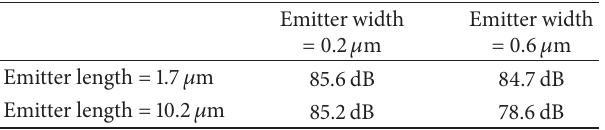
Table3:Thesignal-to-noiseratio(SNR)ofSiGeHBTswithdifferent area at 𝑉 BE = 1.1 V and 𝑉 CE = 3.6 V in the breakdown region. The operating frequency is at 2